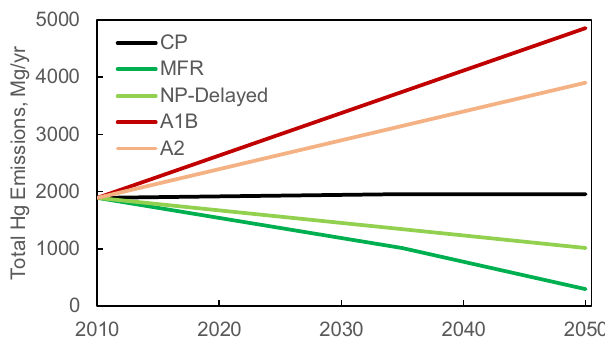
Fig. 2 Projections of global total anthropogenic emission of mercury during 2010 – 2050 based on different emission scenarios. CP (current policy) scenario assumes a near to constant emissions through 2050. A1B and A2 are for business as usual and a divided world scenarios with increasing emissions, respectively. MFR (maximum feasible reduction) assumes the application of the best available technologies and aggressive emission reductions. NP-Delayed (new policy delayed) assumes the 2035 goal of the MFR scenario is delayed to emissions are projected to reduce to 300 Mg y − 1 with the Hg-